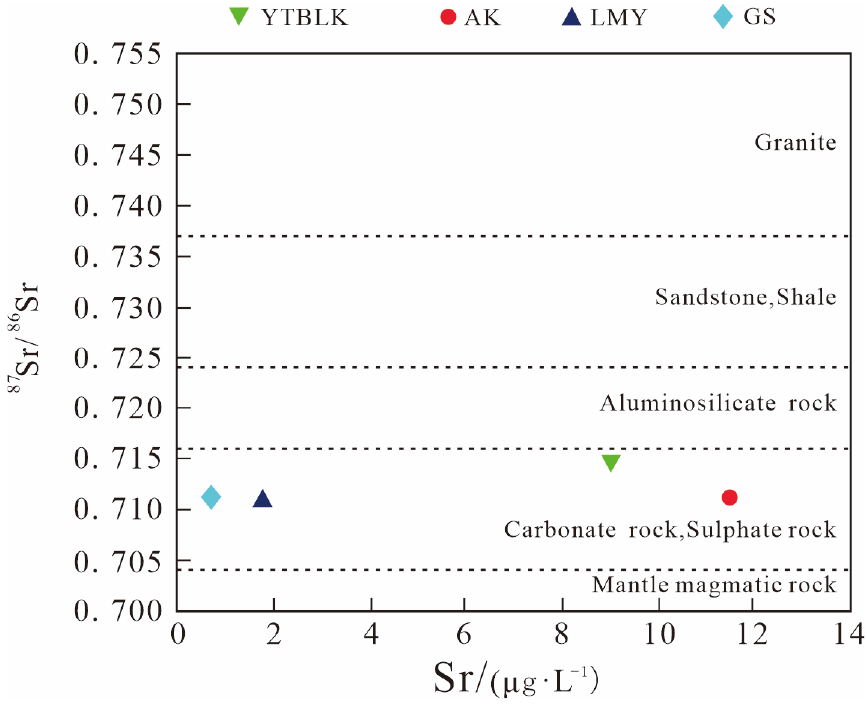
Figure 6. Strontium isotopic composition of the water samples .